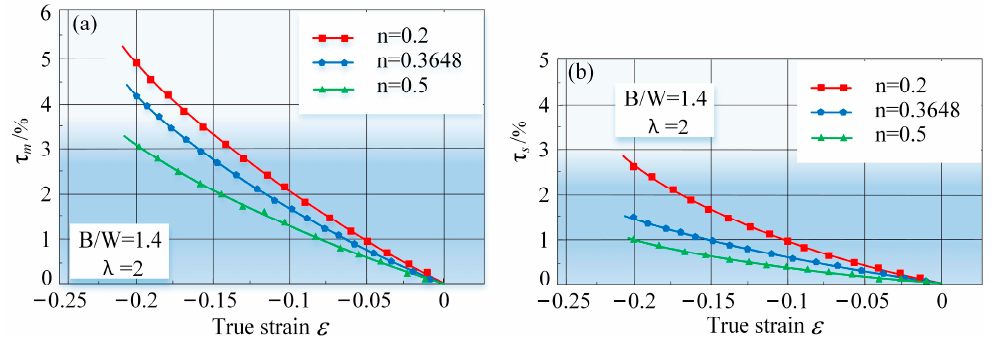
Figure 8. ( a ) Effect of n-values on τ m ; ( b ) Effect of n-values on τ s .